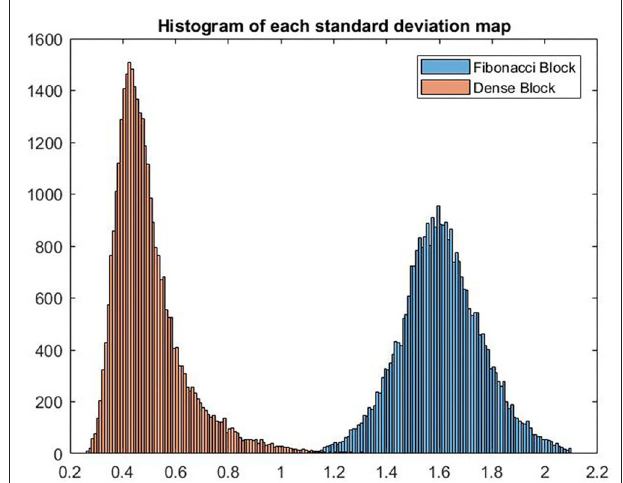
FIGURE 7 | VHistograms of the two standard deviation maps calculated using the feature maps from Fibonacci block and dense block, respectively.